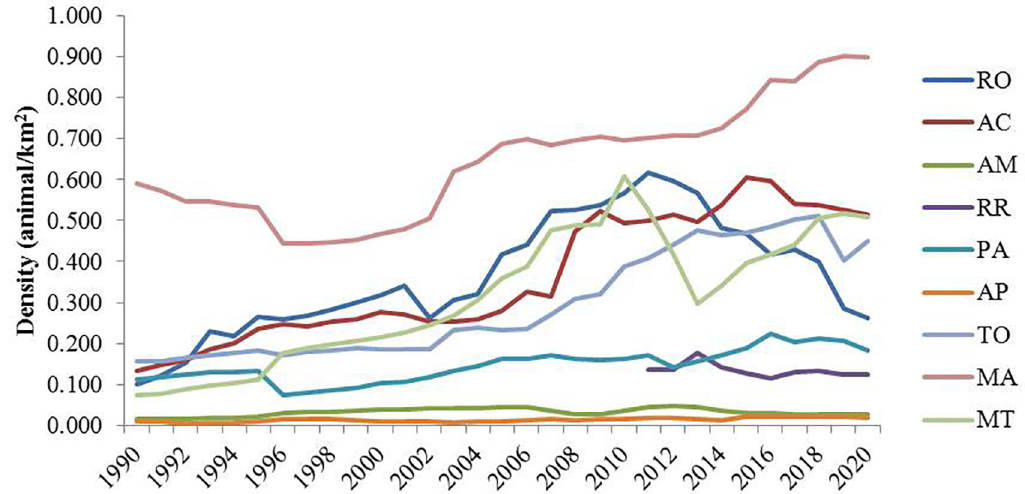
Fig 4. Sheep herd density per km 2 by state (1990–2020). RO, Rondoˆnia; AC, Acre; AM, Amazonas; RR, Roraima; PA, Para´; AP, Amapa´; TO, Tocantins; MA, Maranh ã o; MT, Mato